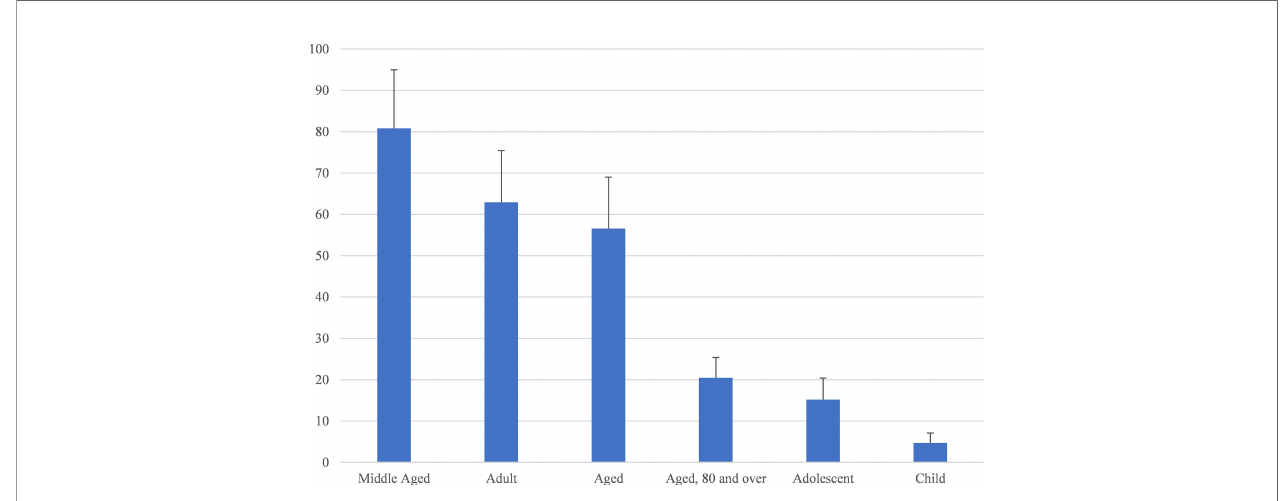
FIGURE 2 | Annual output of literature, broken down by age